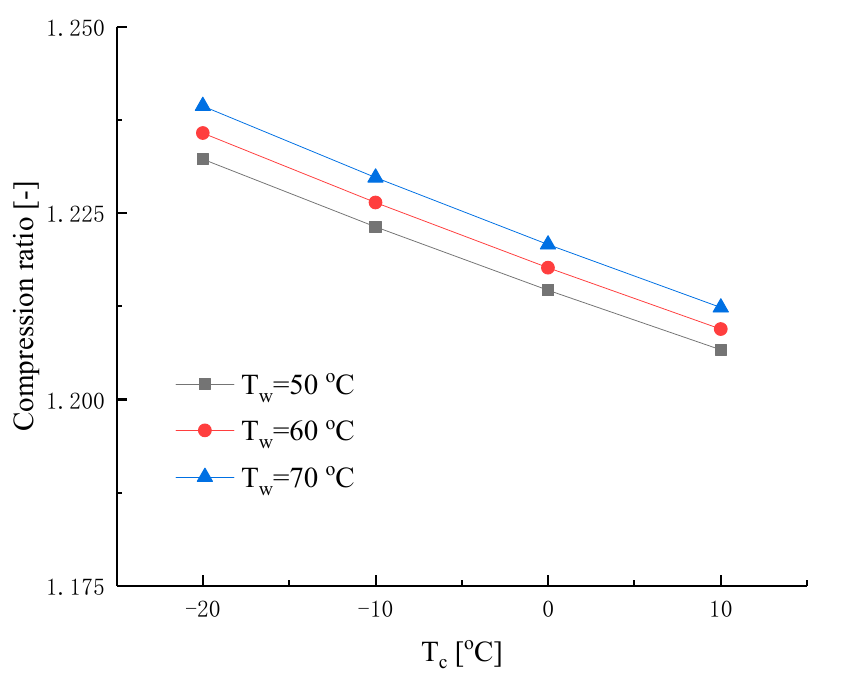
Figure 10. Compression ratio of Vuilleumier’s engine at various conditions.